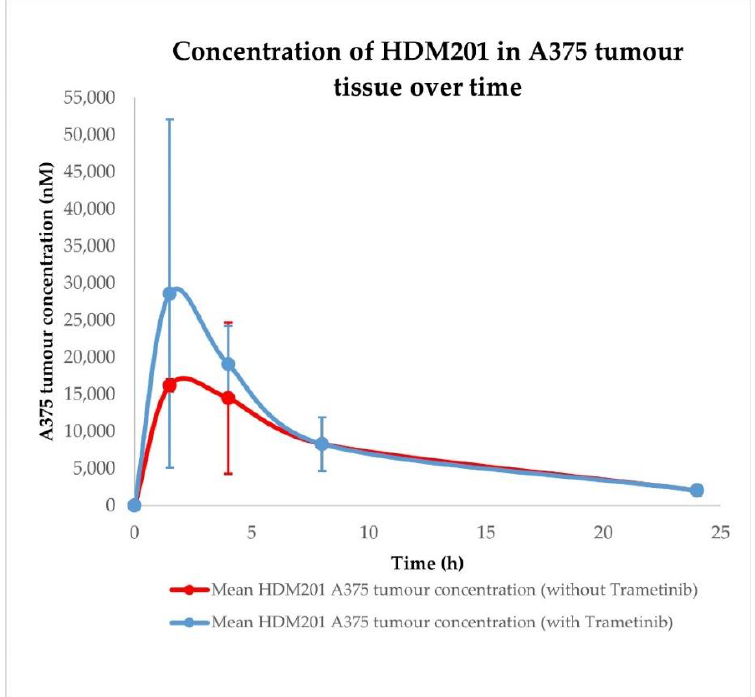
Figure 7. Pharmacokinetic profiles of HDM201 (Siremadlin) in A375 tumour tissue after administra- tion with and without Trametinib. Observed data are means ± standard deviation (SD) from n = 3.